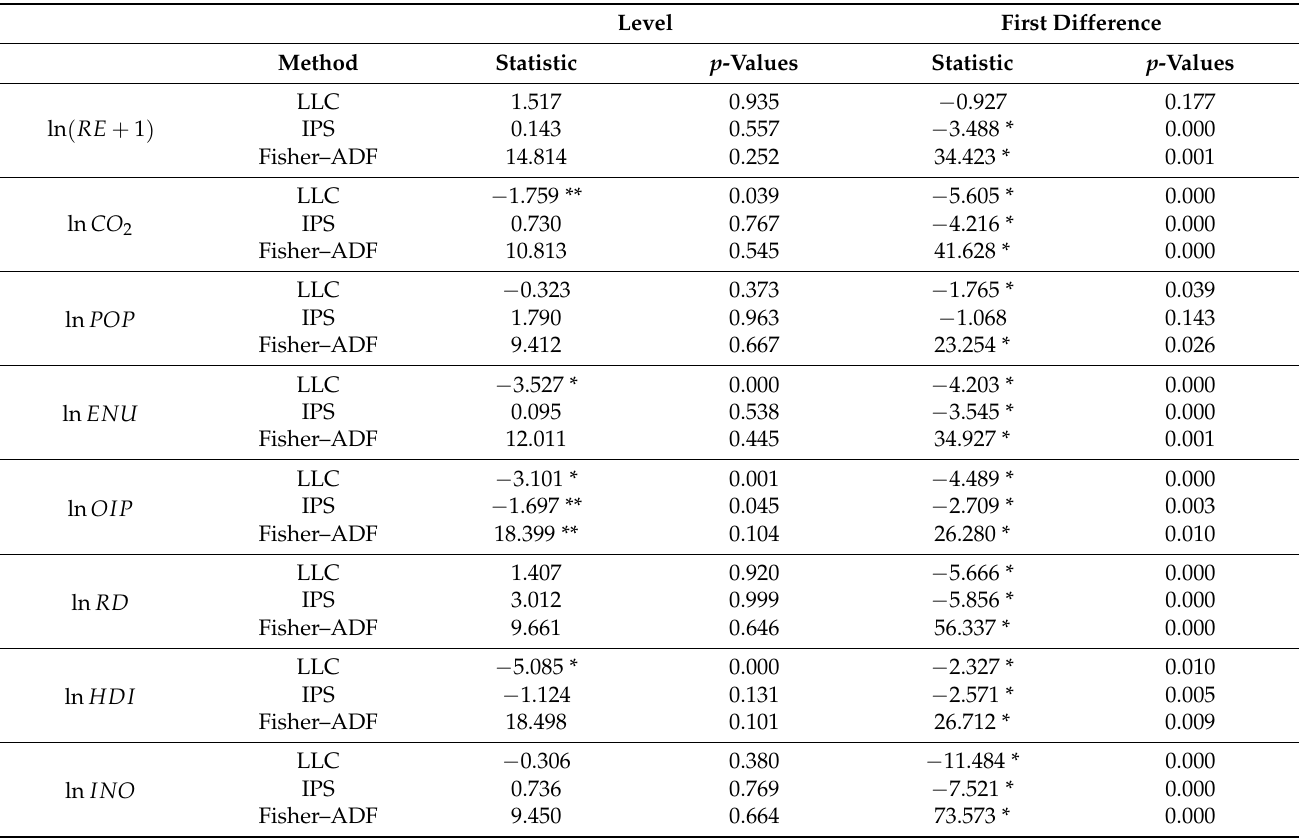
Table 4. Unit root test